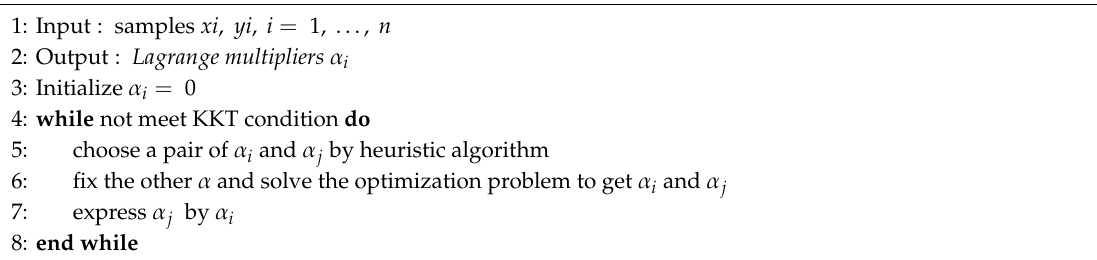
Algorithm 2 Pseudo-code of Sequential Minimal Optimization algorithm